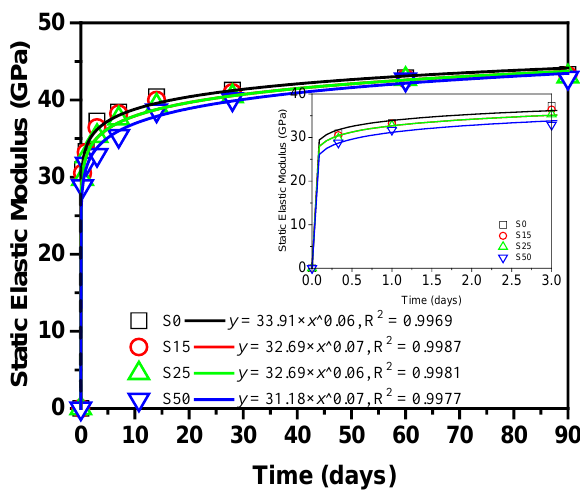
Figure 14. Elastic modulus of steam-cured concrete.